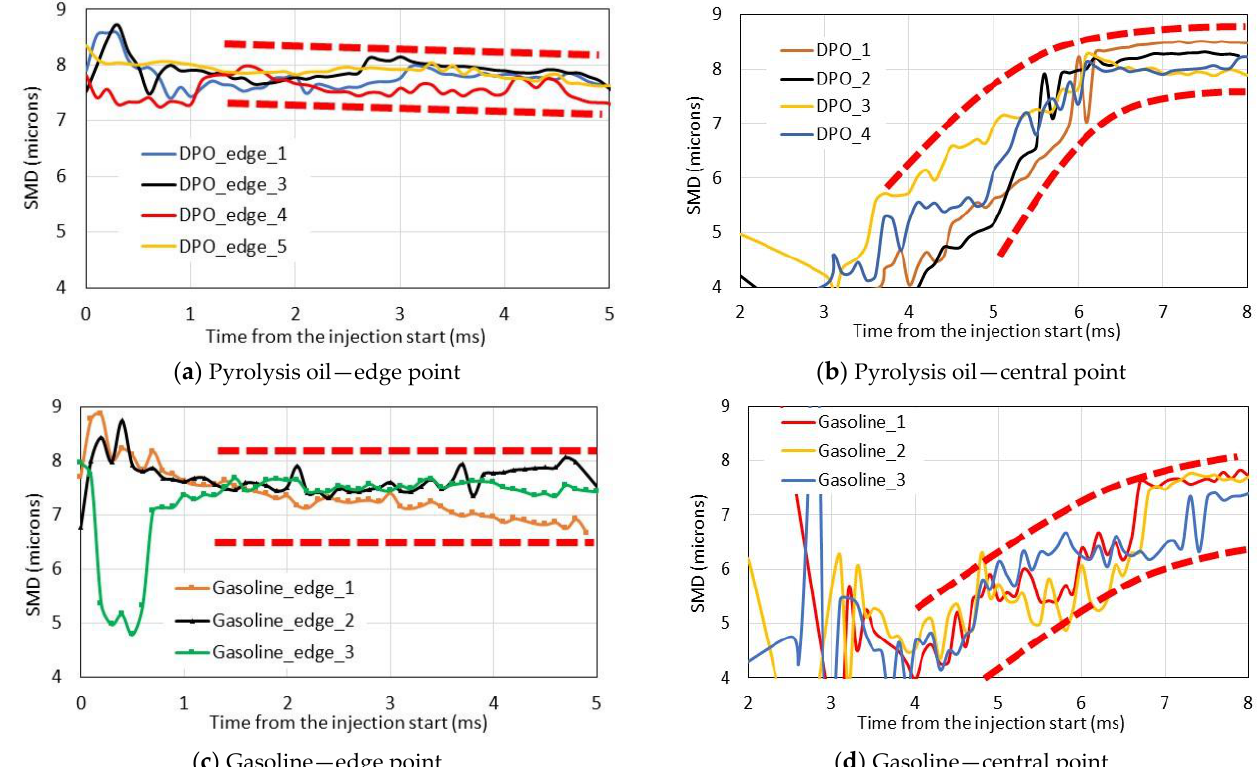
Figure 7. Time histories for averaged SMD for pyrolysis oil ( a , b ) and gasoline ( c , d ) measured at the edge and the central point.